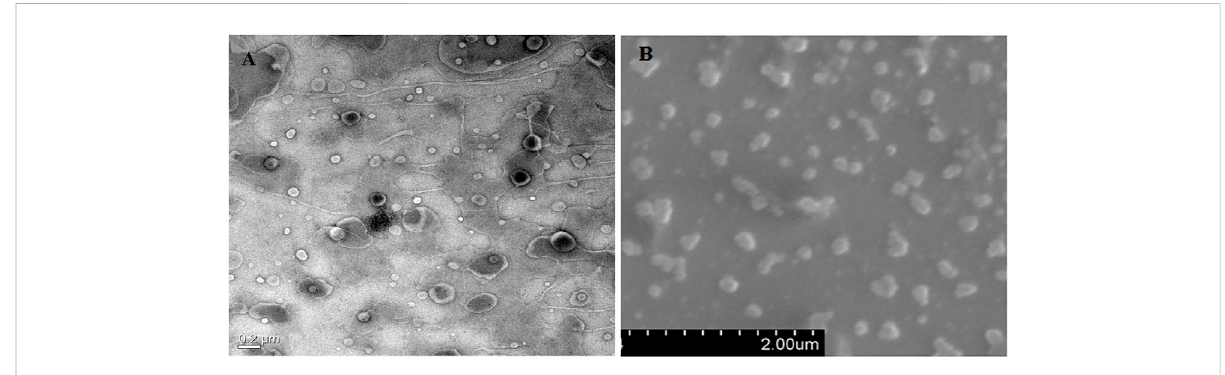
FIGURE 2 Microscopic analysis of shape and size of prepared formulations. (A) HR-TEM analysis and (B) SEM analysis of ACE-loaded